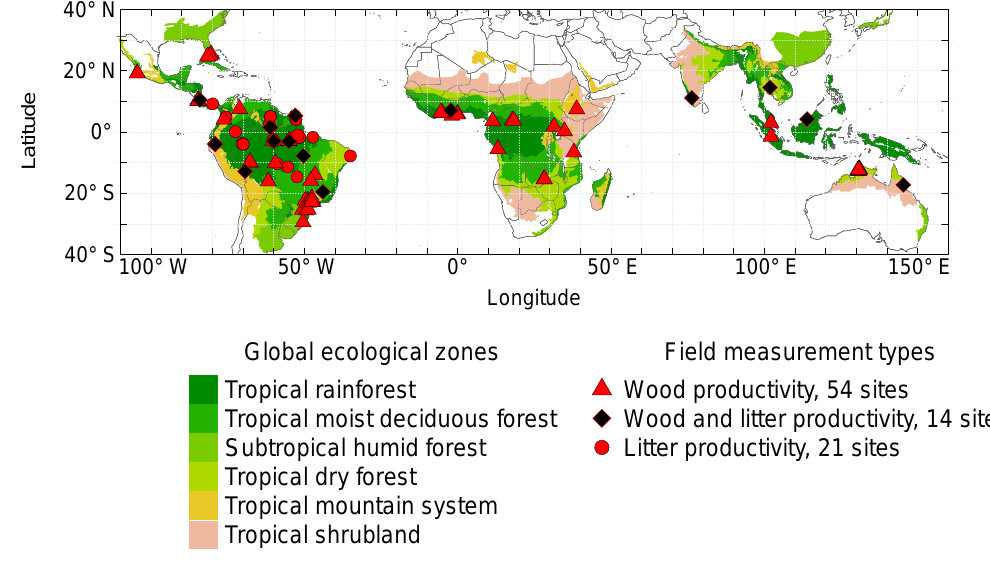
Figure 1. Geographical locations of the 89 observation sites with the field measurement types (wood productivity and/or litter productivity) and global ecological zones (FAO, 2012). Wood productivity is available for 68 sites (54 + 14), litter productivity for 35 sites (21 + 14), and EVI and climate for all the 89 studied sites (54 + 21 +